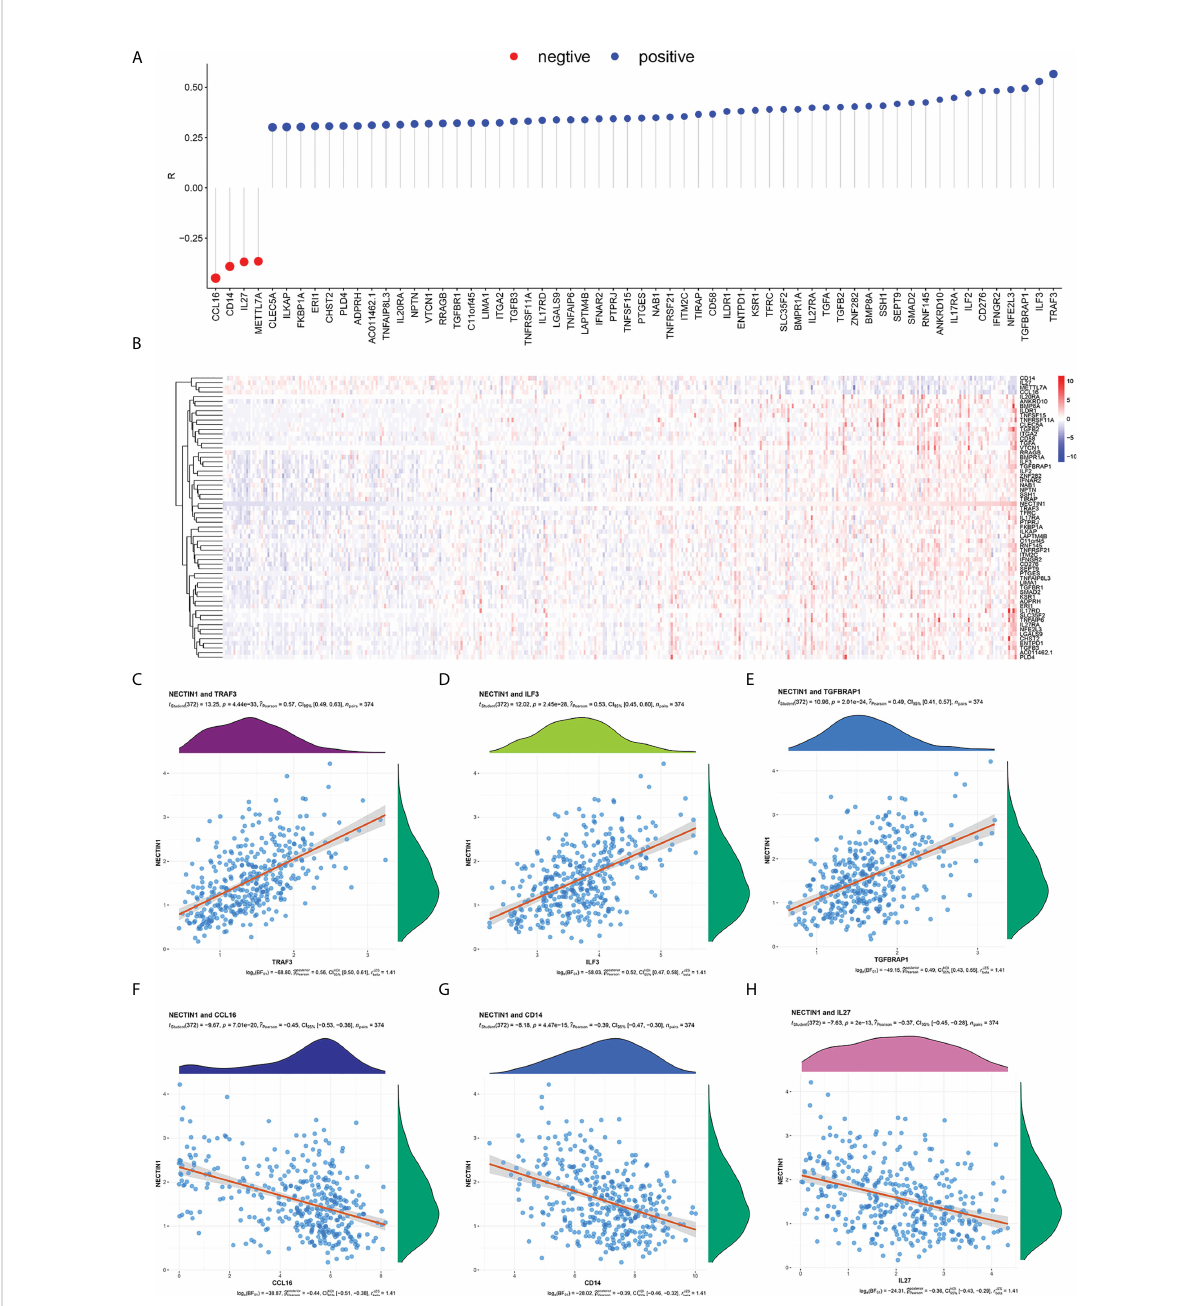
FIGURE 6 Correlation analysis between nectin-1 and immune coexpressed genes in HCC tissues. (A) Analysis of nectin-1 and immune-related coexpression genes. (B) Heat map of nectin-1 and immune-related coexpressed genes. (C) Correlation between nectin-1 and TRAF-3. (D) Correlation between nectin-1 and ILF-3. (E) Nectin-1 and TGFBRAP1. (F) Correlation between nectin-1 and CCL16. (G) Correlation between nectin-1 and CD14. (H) Correlation between nectin-1 and